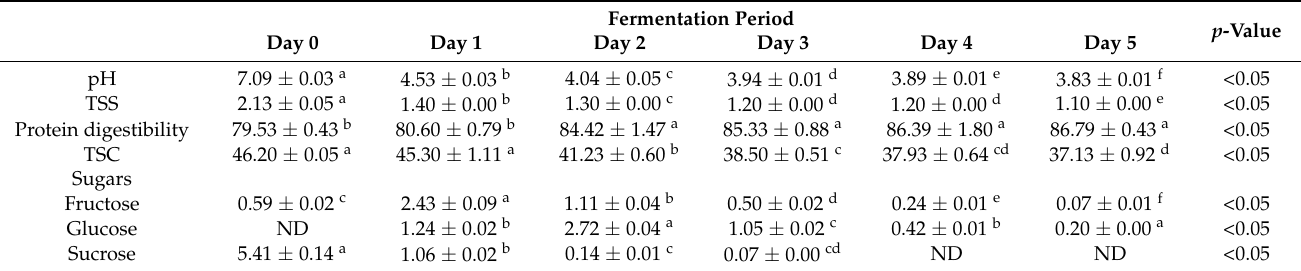
Table 2. Evaluation of the pH, total soluble solids (TSS, Brix), protein digestibility (%), total saponin content (TSC, mg of oleanolic acid per 100 g), and sugar profile (g/L) of the unfermented and fermented lentil–casein protein complex at a ratio of 1.0:0.1 (LCPC